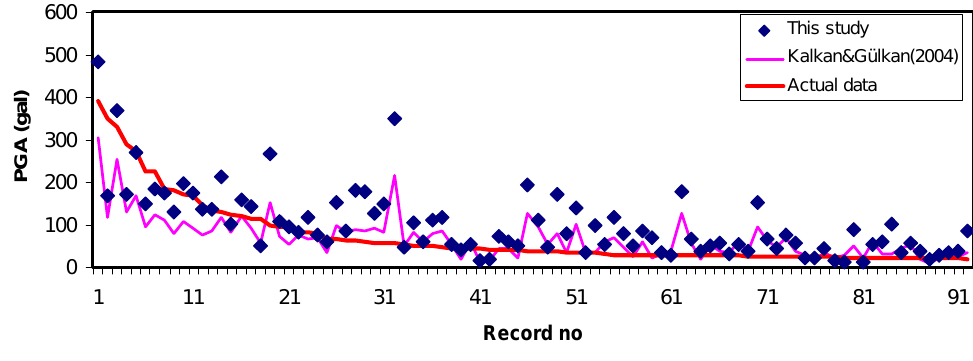
Fig. 11. Distribution diagrams for Kalkan and G¨ulkan Figure 11. Distribution diagrams for Kalkan and Gülkan (2004)